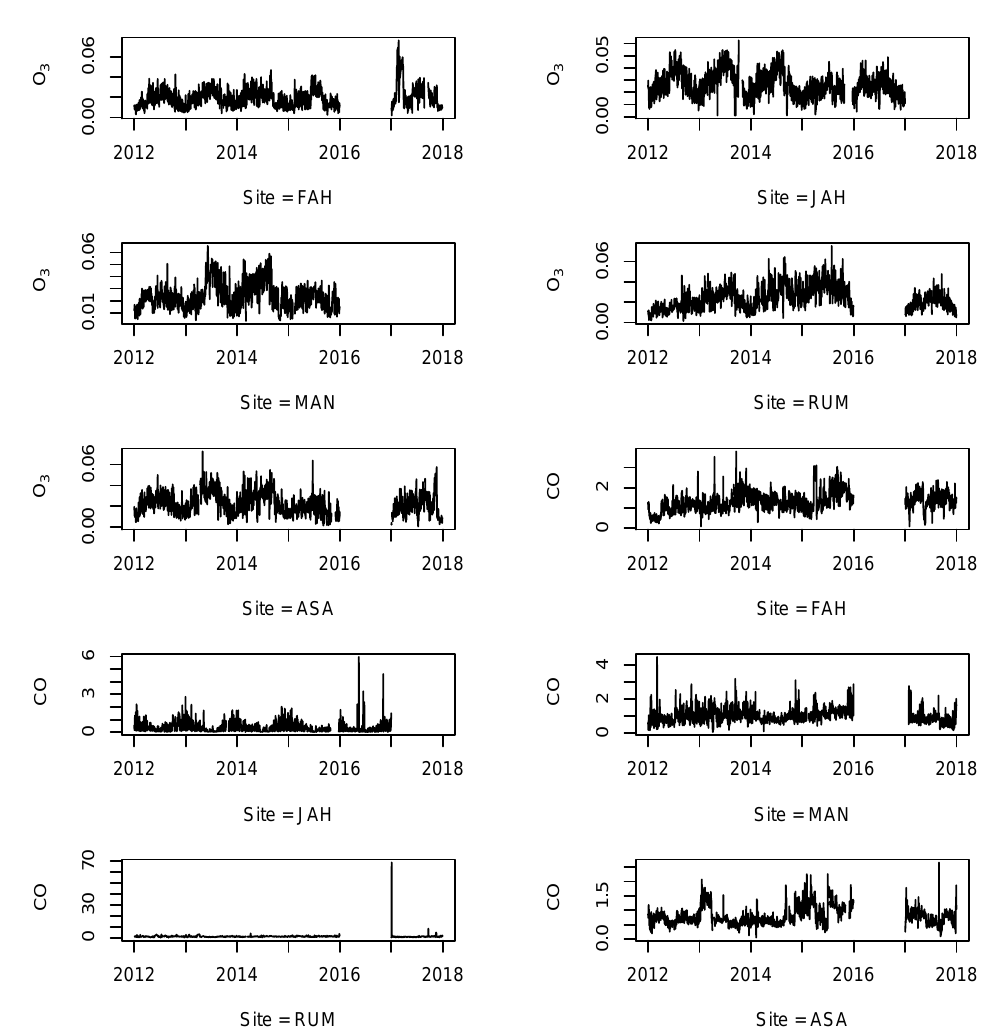
Figure 3. Time-series of air quality monitoring for O 2 and CO from 2012 to 2017, with missing values from five different locations (stations) in the State of